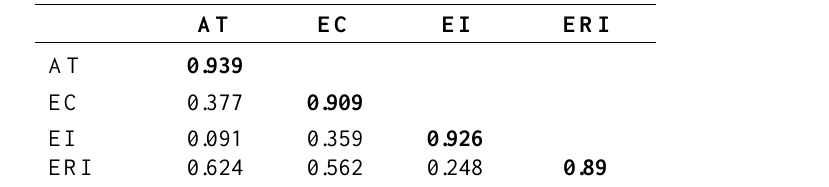
Table 2: Discriminant Validity